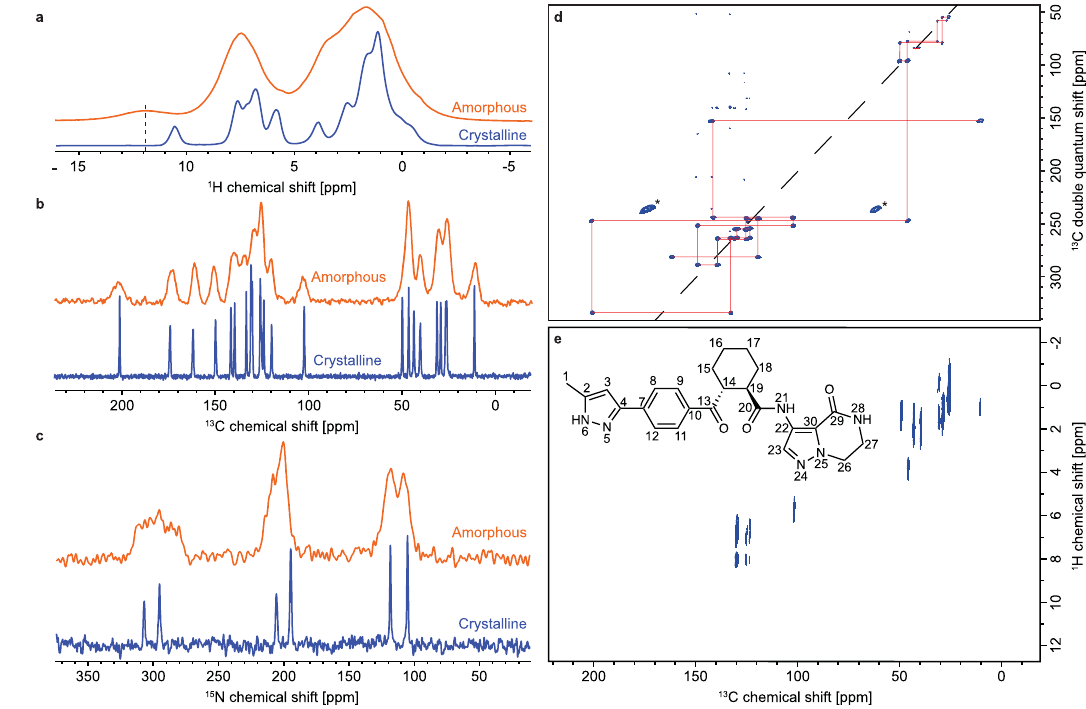
Fig. 1 Solid-state NMR experiments. a 1 H, b 13 C and c 15 N MAS NMR spectra of crystalline (blue) and amorphous (orange) 1 . d 13 C- 13 C DNP enhanced solvent suppressed INADEQUATE and e , 1 H- 13 C HETCOR spectra of crystalline 1 . The dashed black line in ( a ) indicates the chemical shift assigned to the proton bound to N6 in the amorphous sample. In ( d ), the 13 C peaks denoted by a star at 60 and 170 ppm are attributed to impurities introduced during the NMR sample preparation. The chemical structure and labelling scheme of 1 is shown in ( e